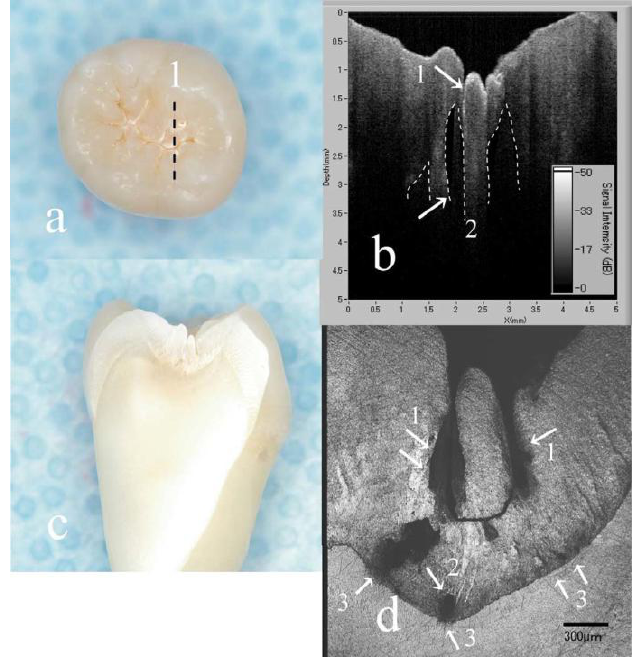
Figure 9. OCT images of the carious lesion and sound regions. ( a ) Visualization of a slightly demineralized tooth. ( b ) SS-OCT image obtained at line 1 in A. The presence of demineralization was determined as a strong scattering signal from the bottom of the fissure (arrow 1). Reflecting OCT signal from the enamel was in some part lacking elliptically beneath the occlusal fissure (arrow 2, dotted line). ( c ) Cross-sectioned view at line 1 in A. ( d ) CLSM image correspond to the cross-sectioned “enamel demineralization” at line 1 in A. CLSM observation clearly confirmed the presence of “hidden lesion” (arrows 1 and 2). Compared with B, the hidden lesion located at the outer enamel was detectable in SS-OCT (arrow 1); however, deeper lesions located near the EDJ could not be visualized in SS-OCT (arrow 2). Since the EDJ vicinity appeared roughened (arrow 3) some of which were reached to the dentine (reprinted from reference